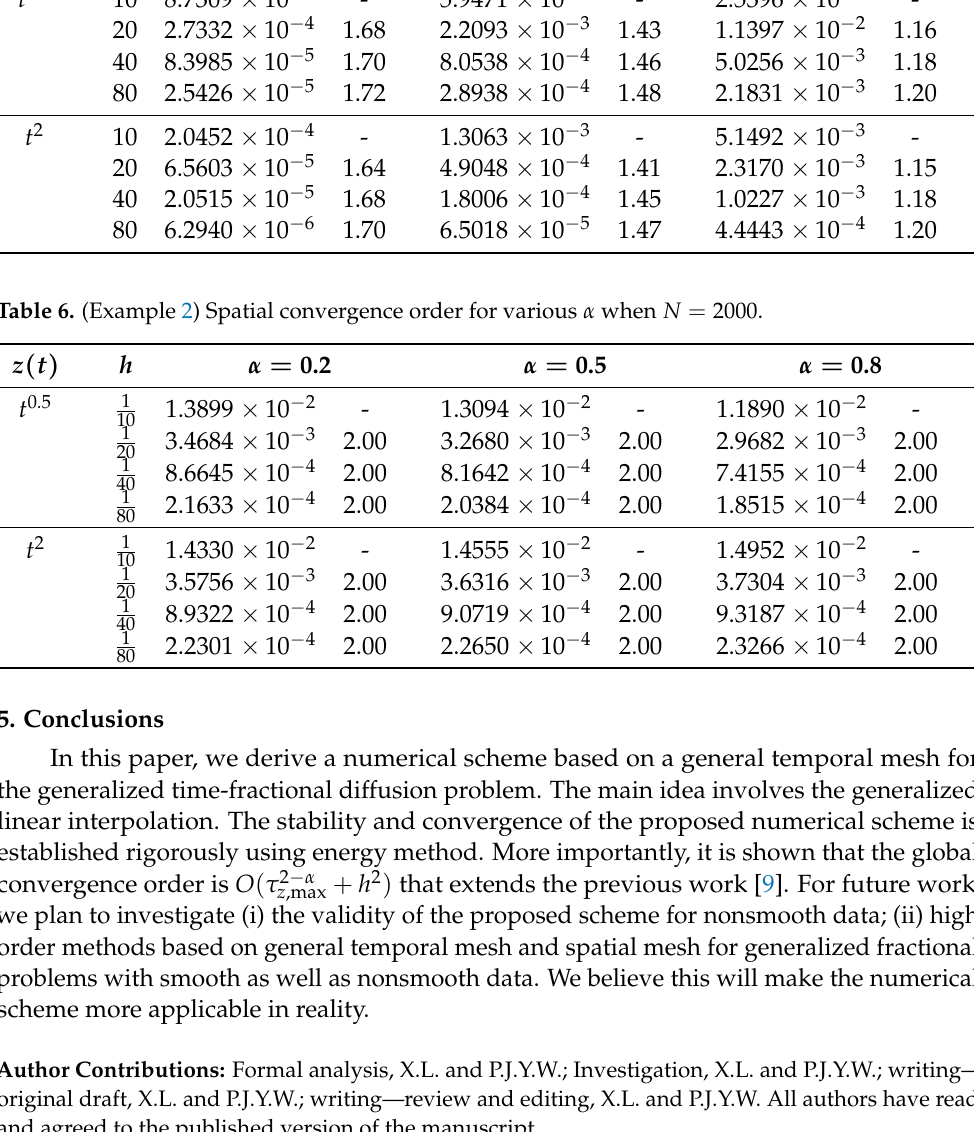
Table 5. (Example 2) Temporal convergence order for various α when h = 1